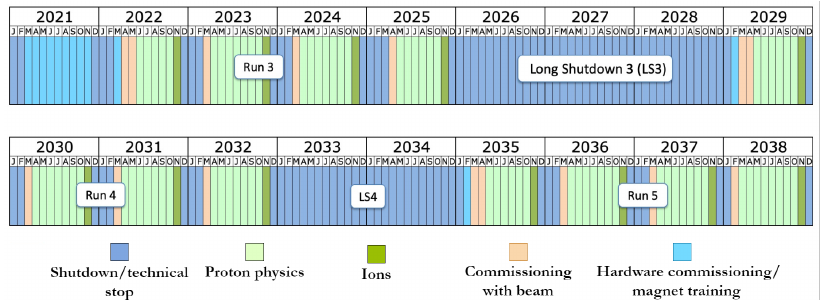
Figure 1. The LHC timeline, and its evolution to the HL-LHC (May 2029 to October 2038) after Long Shutdown